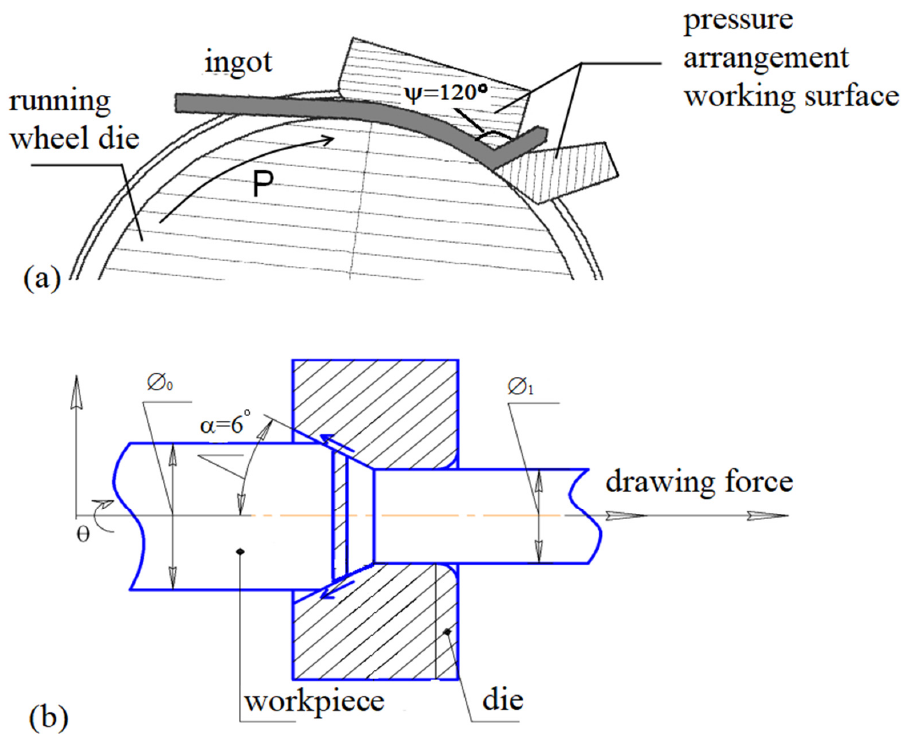
Figure 1. Schematic diagram of the combined processing: ( a ) ECAP-Conform process; ( b ) drawing process.